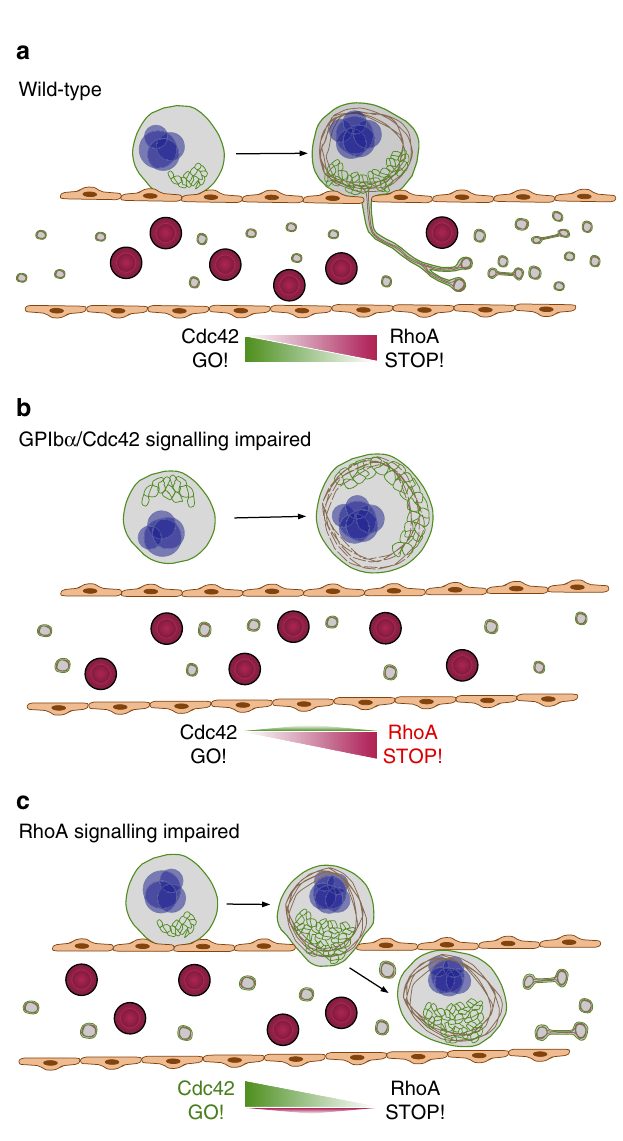
Figure 8 | Model of the Cdc42/RhoA regulatory circuit controlling GPIb a -dependent platelet biogenesis. ( a ) Wt BM MKs polarize their DMS as prerequisite for directed proplatelet release into sinusoidal vessels. This polarization is driven by locally active Cdc42. ( b ) Perturbed intracellular GPIb a -signalling reduces local Cdc42 activity and results in defective DMS polarization, reduced MK localization at BM sinusoids and decreased transendothelial proplatelet formation. ( c ) In the absence of RhoA, Cdc42 activity is locally increased resulting in hyperpolarized MKs entirely transmigrating through the endothelial barrier into sinusoidal Our data from RhoA-deficient mice clearly exclude that size restrictions limit MK transmigration through BM sinusoids and emphasize RhoA as a critical regulator of proplatelet extension across the endothelial barrier by providing a ‘stop’ signal for MK